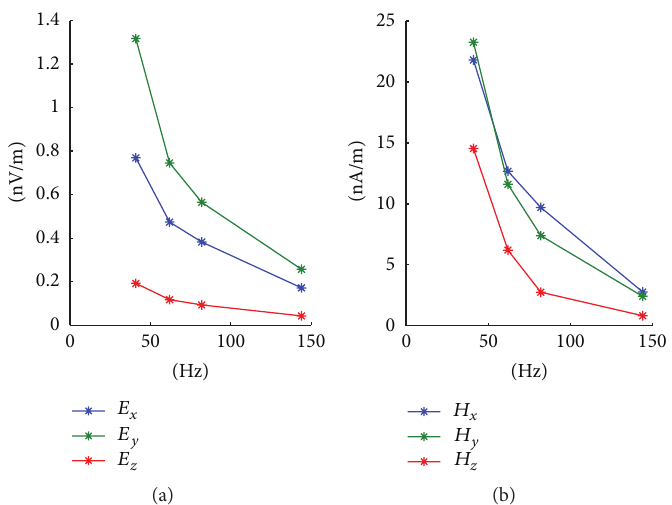
Figure3:Amplitudesforcurrentreducedto1Ainthesource:(a)electric,V/mand(b)magnetic,A/mcomponents,plottedagainstfrequency, Hz